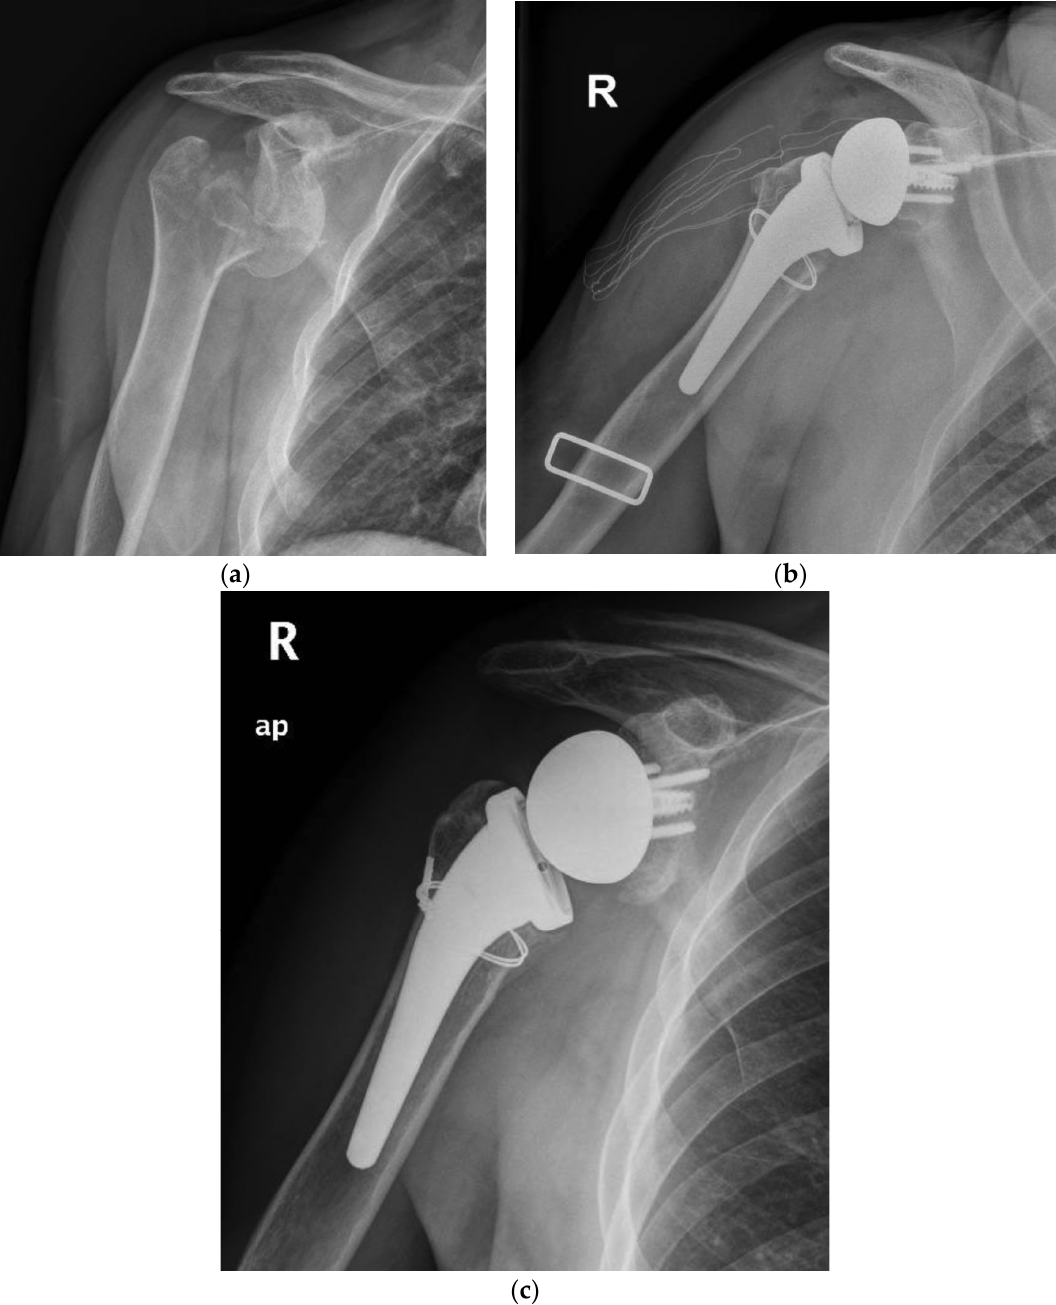
Figure 2. ( a ) Preoperative radiographic image of right shoulder showing acute (Neer four-part) proximal humeral fracture with calcar fragment. ( b ) Immediate postoperative film of right shoulder showing calcar fragment fixation with steel wire cerclage. ( c ) 5.5 years postoperative film of right shoulder showing healed tuberosity and medial calcar.